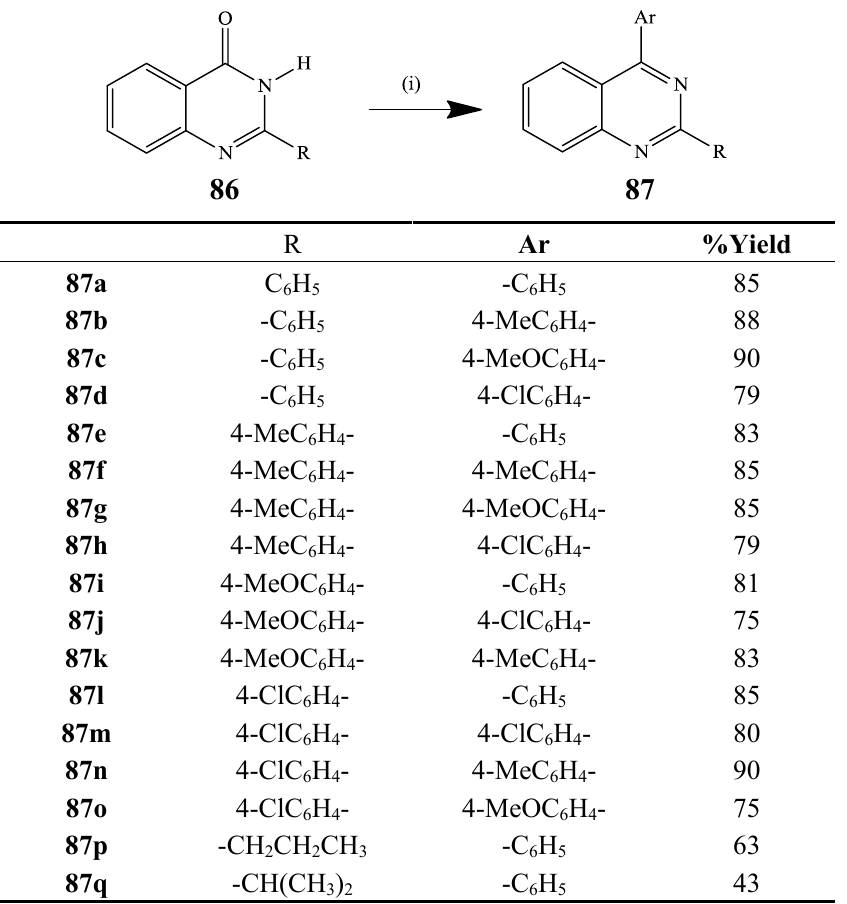
Reagents and Conditions : (i) ArB(OH) 2 , K 2 CO 3 , PdCl 2 (PPh 3 ) 2 , TsCl, THF–H 2 O (20:1, v/v), 60 °C. Scheme 29. The Suzuki cross-coupling reaction of N -(3-fluorophenyl)-6-iodoquinazolin-4-amine.